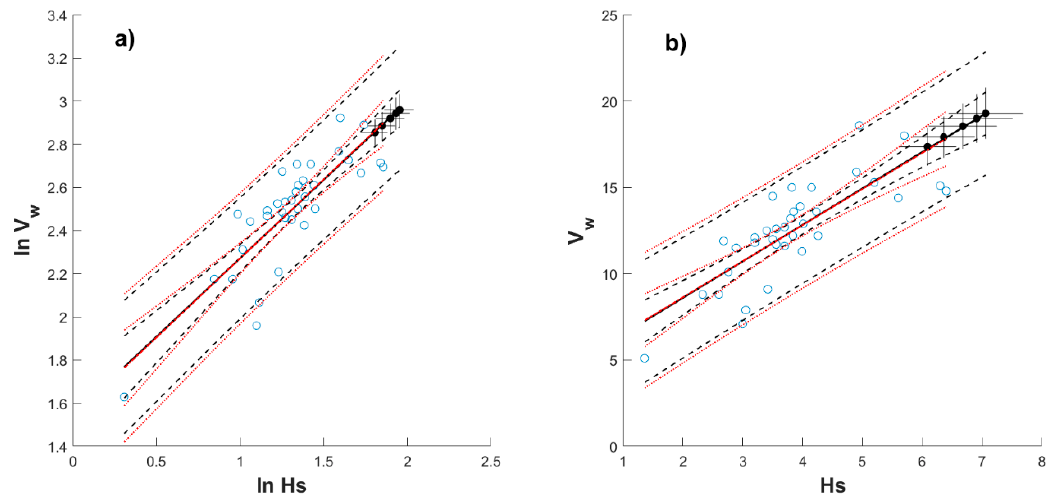
Figure 10. Regression lines and confidence intervals including (solid and dashed lines, respectively) and excluding (dashed–dotted and dotted lines, respectively) T -yr values for February; ( a ) and ( b ) for logarithmic space and linear space, respectively. Filled circles represent T -yr values with embedded perpendicular lines indicating confidence intervals from GEV models.